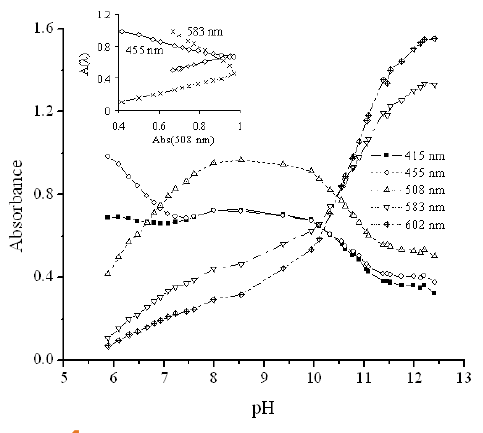
Figure 4. Titration curves A vs. pH for 4-[(2,4-dinitrophenyl) λ diazenyl]-l,2-benzenediol (D3). The inset shows the corresponding plot for A-diagrams.